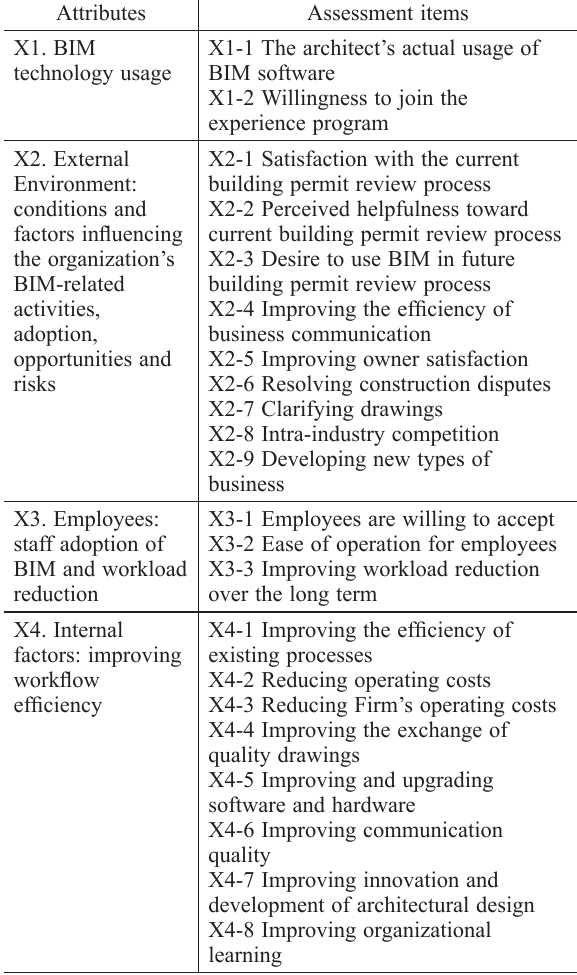
Table 1. BIM acceptance assessment Attributes Assessment